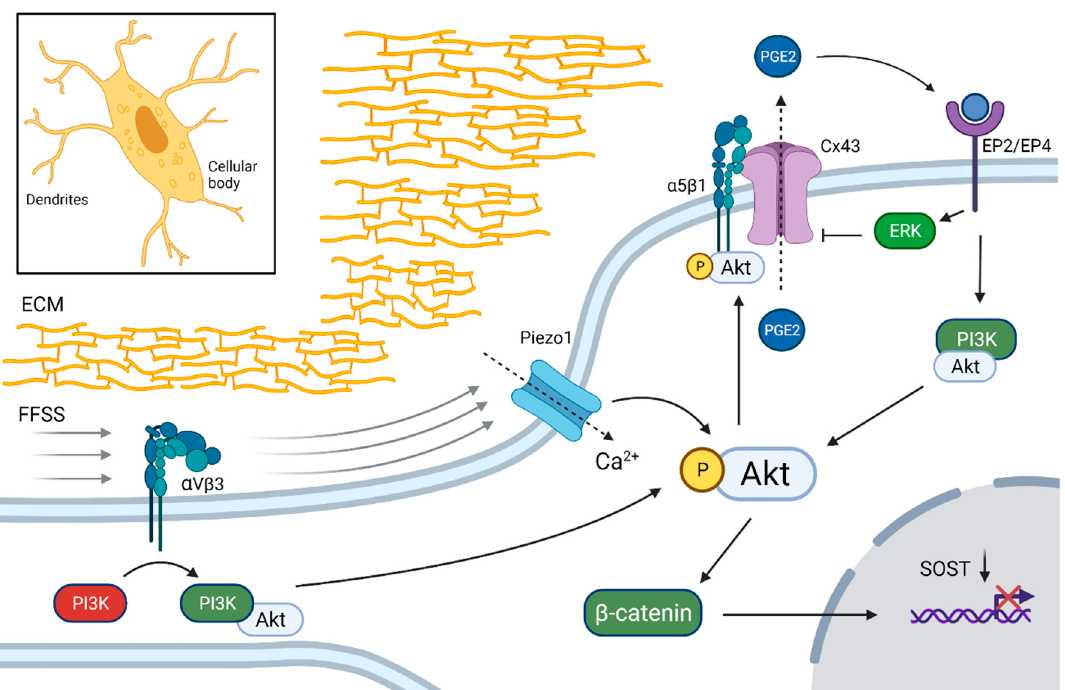
Figure 1. Down-regulation of SOST in osteocytes by mechanotransduction. Integrin α V β 3 in dendritic processes sense fluid flow shear stress (FFSS) applied on the extracellular matrix (ECM). The subsequent activation of phosphoinositide 3-kinase (PI3K) phosphorylates Akt, which activates integrin-mediated connexin 43 (Cx43) channel opening on the cellular body. Prostaglandin E2 (PGE2) is transported out of the osteocyte and binds to EP2 and EP4 receptors, which further activates the Akt and extracellular signal-regulated kinase (ERK) pathways and β -catenin, which down-regulates SOST expression. FFSS activates also Ca 2+ influx through Piezo1 channels, which enables enhanced Akt activation. Black dotted arrows indicate transport through membrane channels. Created with BioRender.com, accessed on 15 February